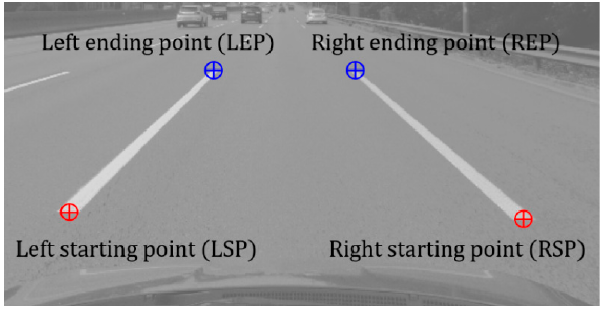
Figure 11. Types of lane endpoints. Table 2. Number of samples used for training and testing the lane endpoint verifiers.